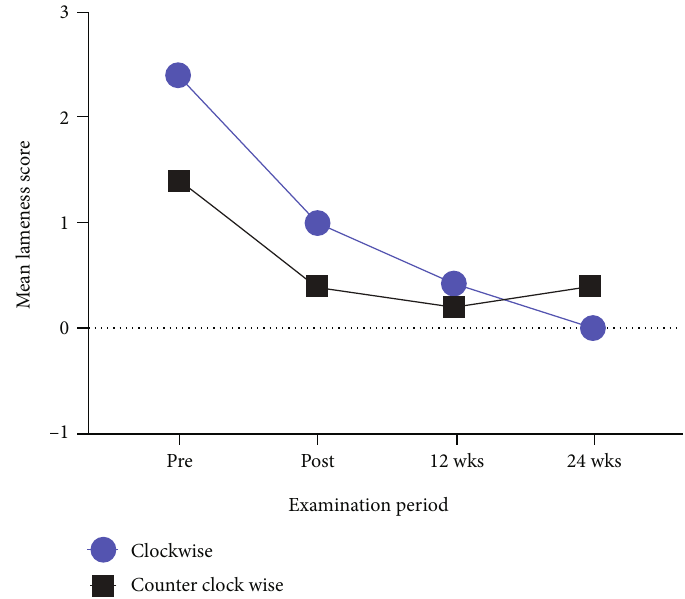
Figure 4: The mean lameness score on the right forelimb following the hard surface lunging in the clockwise and counterclockwise directions. Gait analysis was performed before shoeing, immediately postshoeing, and 12 weeks and 24 weeks postshoeing.